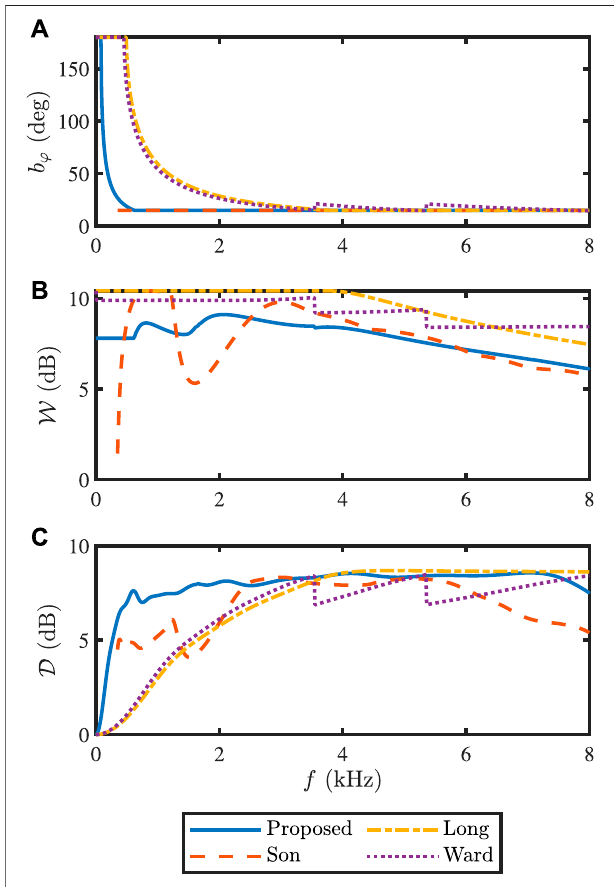
FIGURE 4 | (A) Beamwidth, (B) WNG, and (C) narrowband directivity factorasafunctionoffrequency:proposed(solidline),Son(dashedline),Long (dash-dot line), and Ward (dotted line). The obtained W [ 350 Hz , 8 kHz ] are respectively 7.8, 7.6, 9.5, and 9.2 dB. The obtained D I [ 350 Hz , 8 kHz ] are respectively 8.1, 6.7, 6.5, and 6.3 dB.